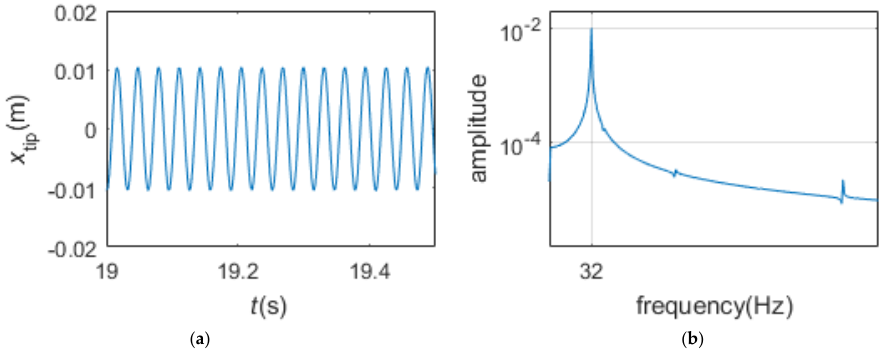
Figure 8. ( a ) The steady-state response of the blade tip; ( b ) the frequency spectrum of the blade tip.